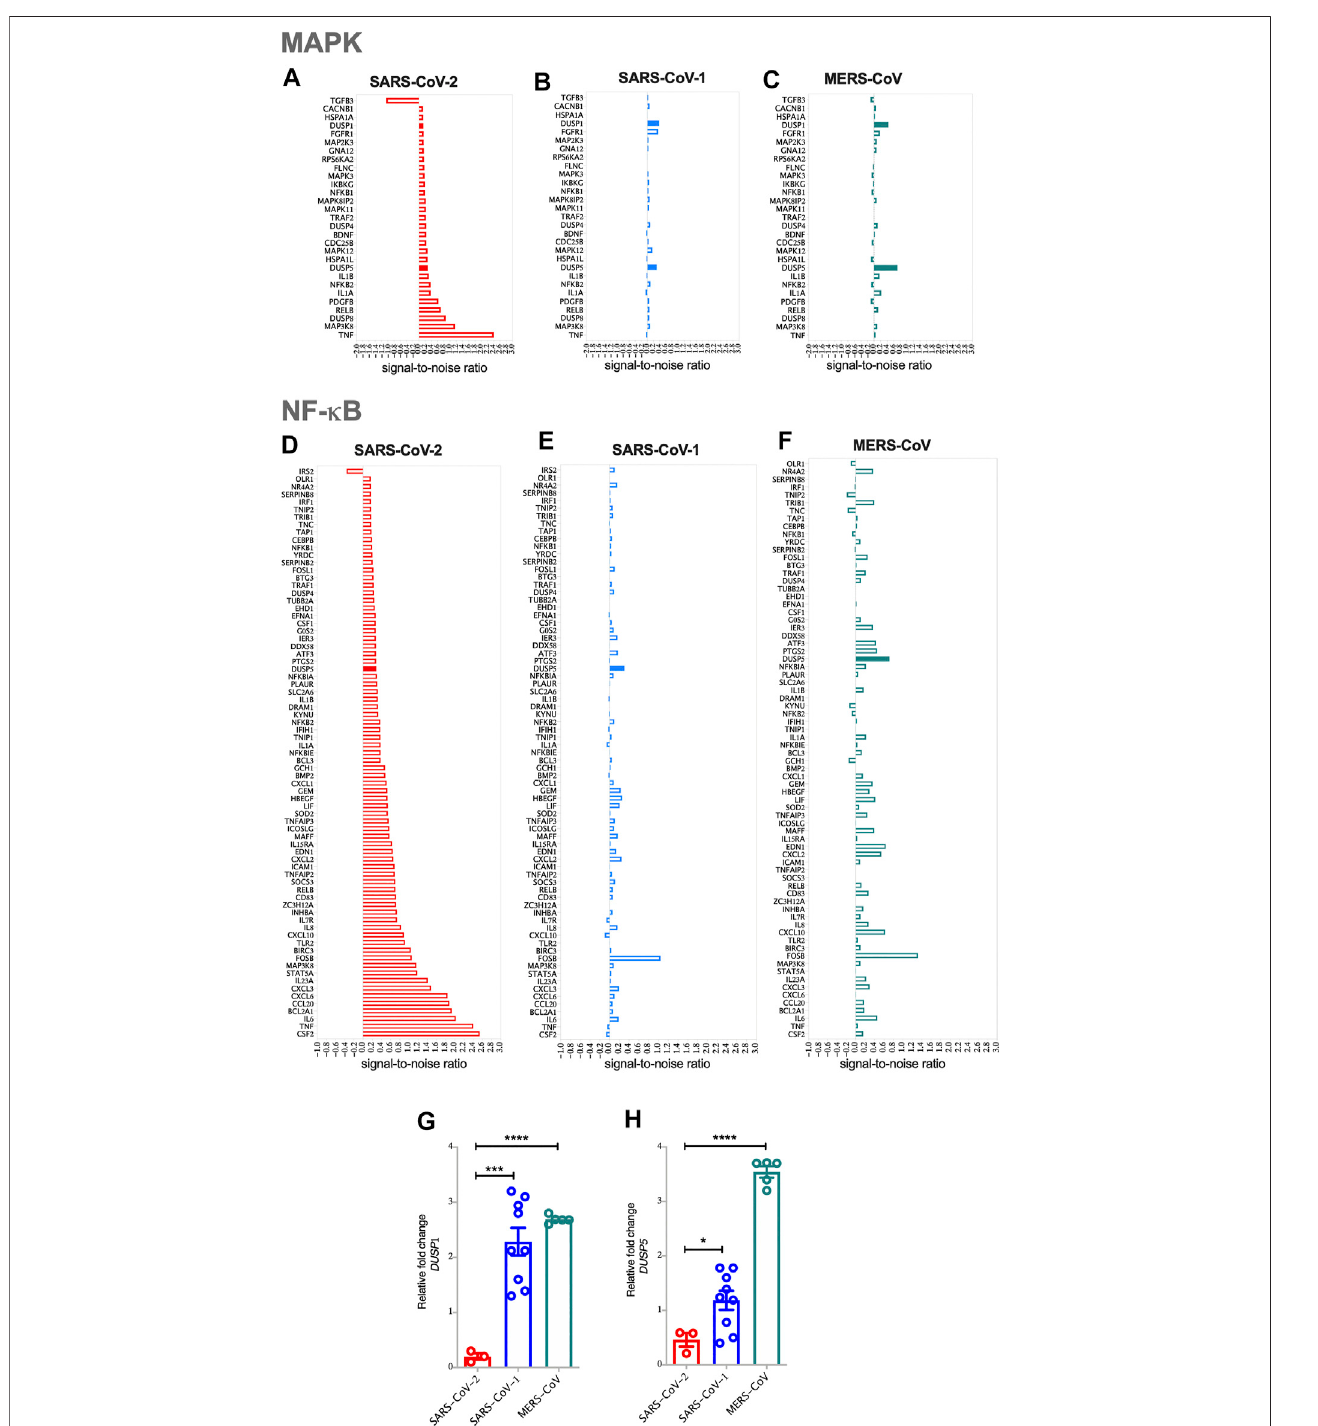
FIGURE 1 | SARS-CoV-2 activates MAPK and NF- κ B pathways via the reduced expression of DUSP1 and DUSP5 expression compared to other coronaviruses (A) Enrichment of MAPK pathway in SARS-CoV-2 infected human AECs along with the expression levels of enriched MAPK pathway related genes in SARS-CoV-2 infected AECs (ES (cid:1) 0.437; NES (cid:1) 1.57) (B) Enrichment of MAPK pathway in SARS-CoV-1 infected human AECs (ES (cid:1) 0.489; NES (cid:1) 1.51) (C) Enrichment of MAPK pathway in MERS-CoV infected human AECs (ES (cid:1) 0.432; NES (cid:1) 1.37) (D) Enrichment of NF- κ B pathway in SARS-CoV-2 infected human AECs along with the expression levels of enriched NF- κ B pathway related genes in SARS-CoV-2 infected AECs (ES (cid:1) 0.663; NES (cid:1) 1.24) (E) Enrichment of NF- κ B pathway in SARS-CoV-1 infected human AECs (ES (cid:1) 0.643;NES (cid:1) 1.6) (F) EnrichmentofNF- κ Bpathway inMERS-CoV infected human AECs (ES (cid:1) 0.704;NES (cid:1) 1.13). Enrichment Score(ES), Normalized enrichment Score (NES) (G,H) Gene expression of DUSP1 and DUSP5 in SARS-CoV-2, SARS-CoV-1, or MERS-CoV infected human AECs, 24 h post- infection. Representative data shows lower expression level of DUSP1 and DUSP5 following SARS-CoV-2 infection as compared to other coronaviruses. Two-way comparison was done using t -test or Mann-Whitney U test, depending on the skewness of the data. *** p < 0.001, **** p < 0.0001.